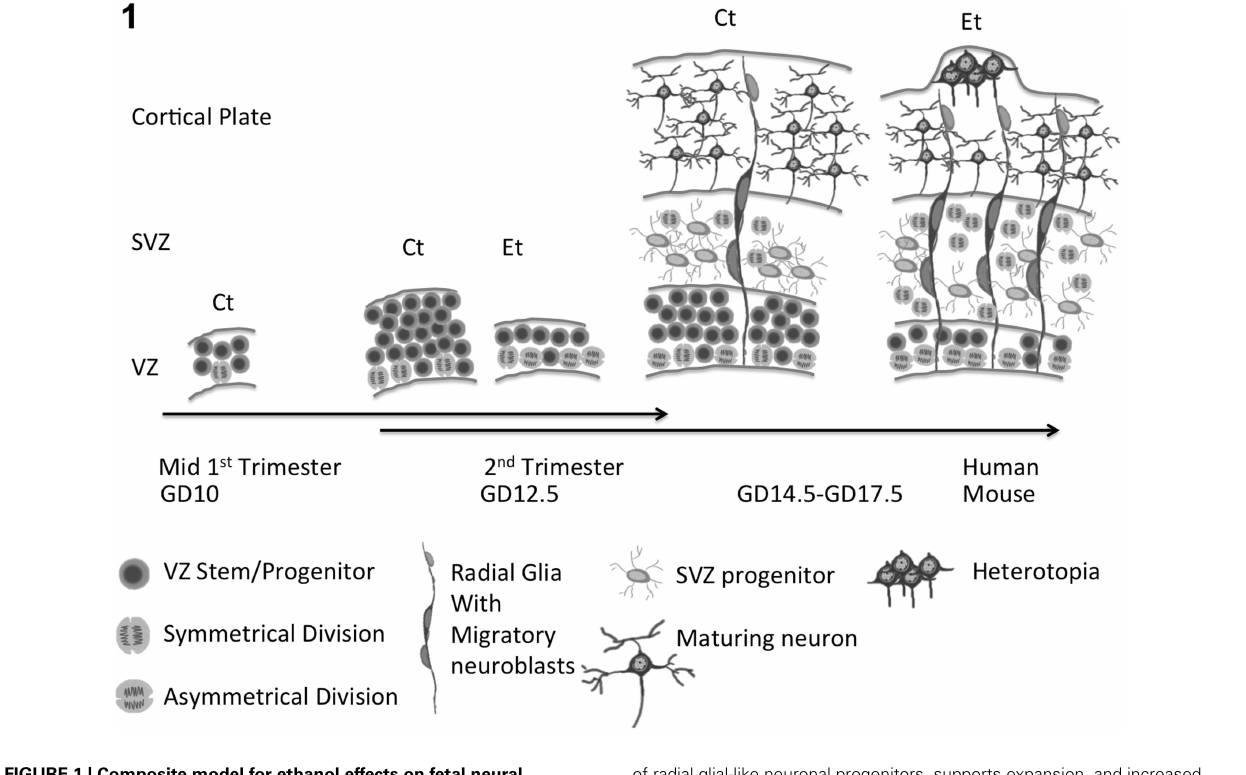
of radial glial-like neuronal progenitors, supports expansion, and increased proliferation of neuronal progenitors in the sub-ventricular zone (SVZ) and increased migration of neuronal progenitor cells out of theVZ and SVZ, leading to the formation of heterotopias or displaced neuronal